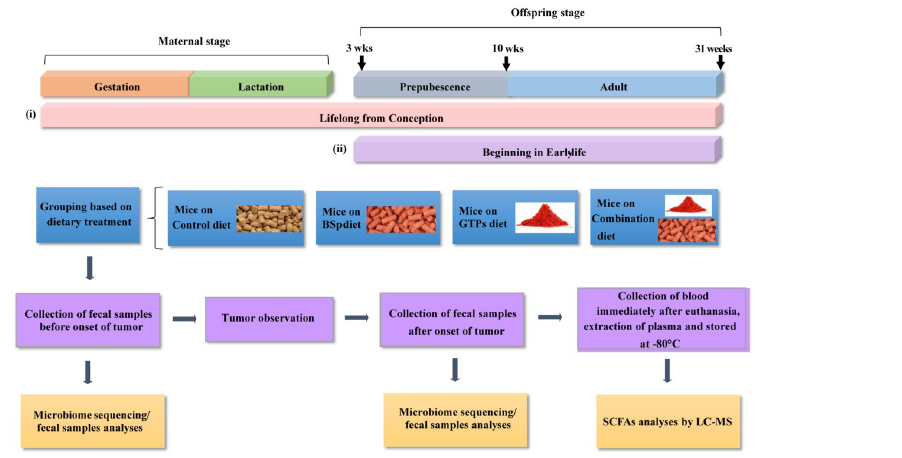
Fig 1. Schematic representation of study